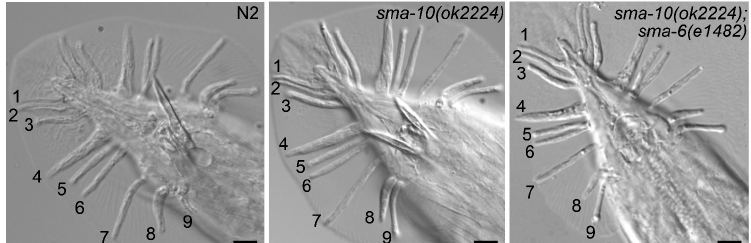
Figure 2. Male tail development is not modulated by SMA-10. Young adult males were anesthetized with 1% sodium azide and mounted in 2% agar pads. Worms were observed at ×1000 amplification under Nomarski interference contrast optics with an Axio Zeiss Imager.A1 microscope. Scale bar represents 10 μ m. Numbers denote the position of the rays.